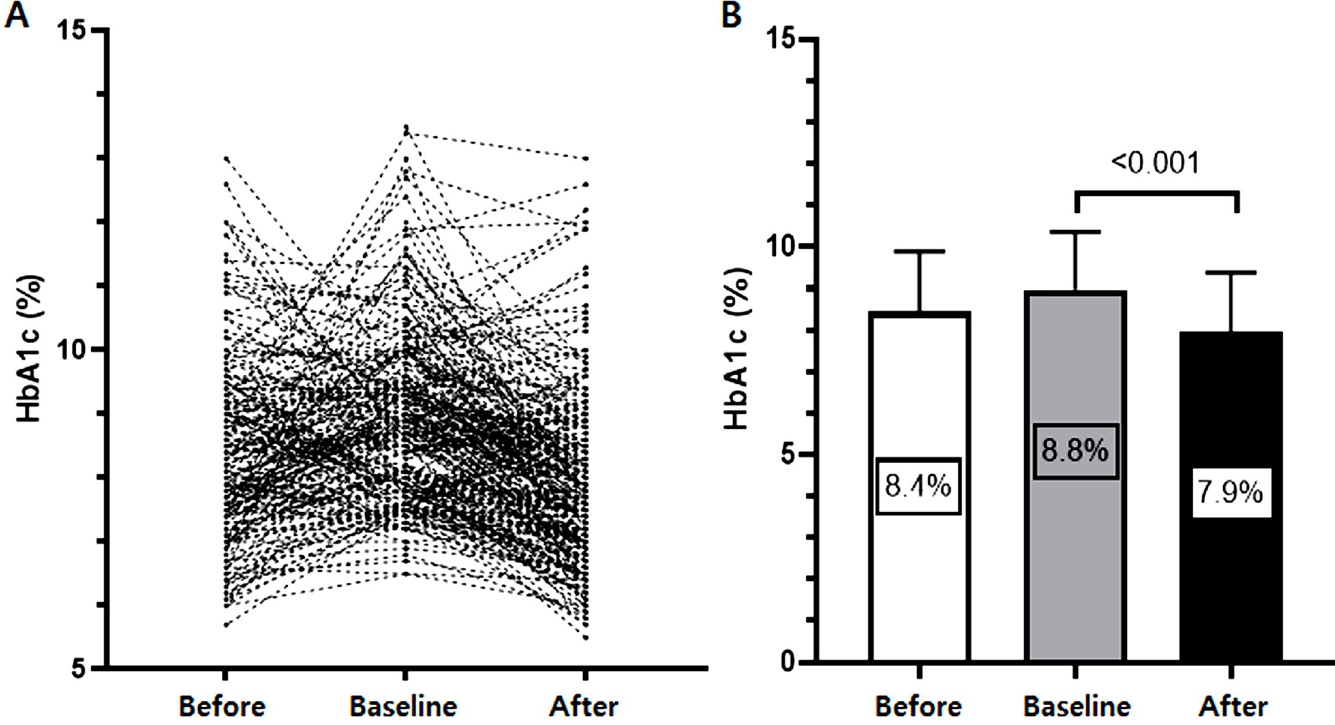
Fig 1. Glucose-lowering efficacy. (A) HbA1c levels at pre-, baseline, and post-dulaglutide use. (B) Once-weekly dulaglutide use significantly reduced HbA1c level.